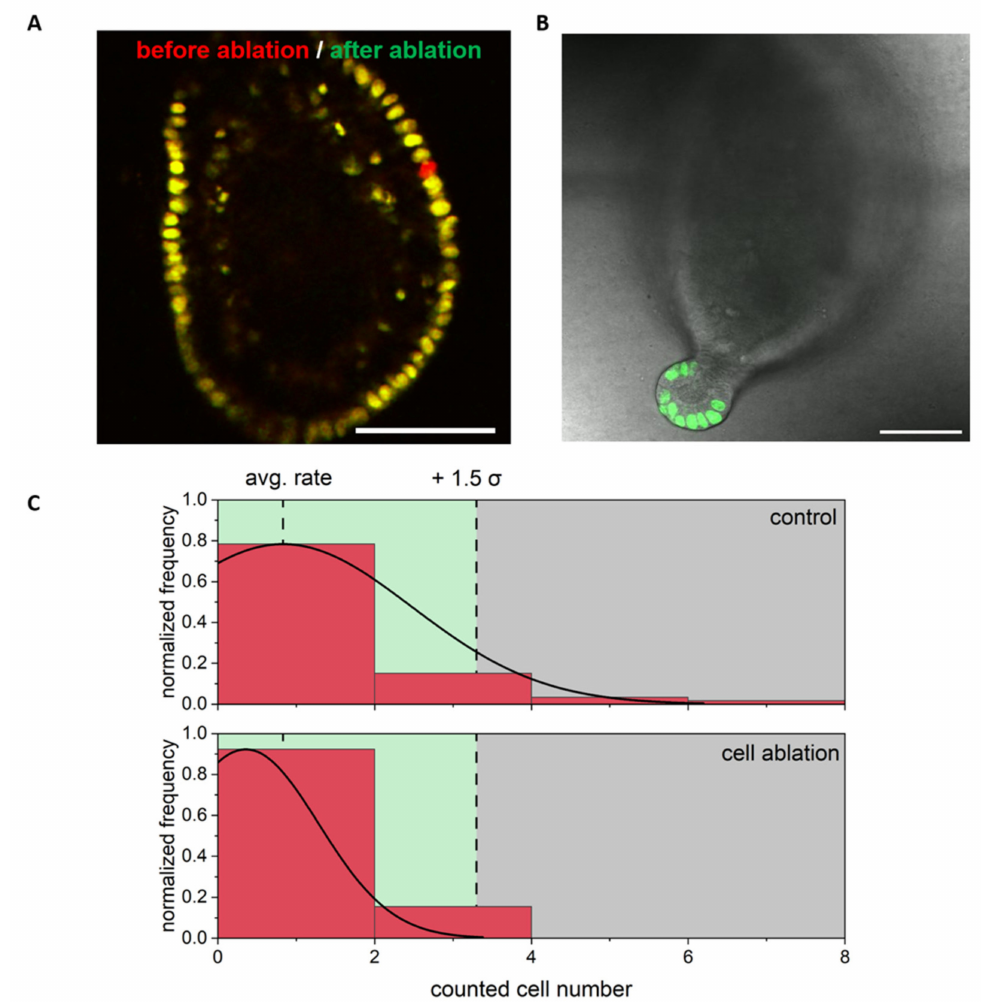
Figure 4. Regeneration and proliferation after ablation of a single cell in the differentiated area. ( A ) Overlay of an image before (red) and after (green) cell ablation. Only the missing cell is red colored. ( B ) Exemplary stack image (confocal microscopy stack merged of EdU and transmittance images) from the same colonoid as shown in A after fixation and EdU staining, showing no EdU positive cells outside of the crypt. ( C ) Frequency of counted EdU positive cells: In the differentiated zone proliferation was not increased and no statistical differences between control and ablation group were observed. Scale bars 50 µ m and n ≥ 13 colonoids. The full 3D dataset to B is provided as Supplementary Video